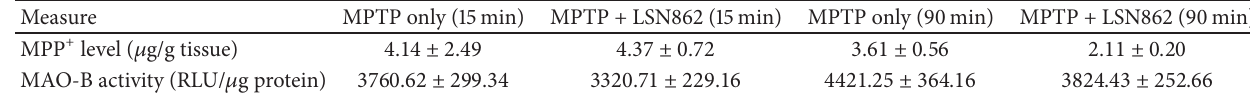
Table 1: Striatal MPTP metabolism is not affected by LSN862. C57BL/6 mice received MPTP (i.p. 30mg/kg × 5 days) or MPTP + LSN862 (p.o. 30mg/kg). Mice were euthanized 15 or 90 minutes after the last dose of MPTP and 24hrs after the last dose of LSN. Groups were for 15min vehicle + MPTP (𝑛 = 6) , 30 mg/kg + LSN + MPTP (𝑛 = 6) ; for 90 min: vehicle + MPTP (𝑛 = 7) , 30 mg/kg LSN + MPTP (𝑛 = 6) . No significant differences between groups were detected (two-tailed independent 𝑡 -tests). Values represent mean ± SEM. Measure MPTP only (15min) MPTP + LSN862 (15min) MPTP only (90min) MPTP + LSN862 (90min) MPP + level ( 𝜇 g/g tissue) 4.14 ± 2.49 4.37 ± 0.72 3.61 ± 0.56 2.11 ± 0.20 MAO-B activity (RLU/ 𝜇 g protein) 3760.62 ± 299.34 3320.71 ± 229.16 4421.25 ± 364.16 3824.43 ±